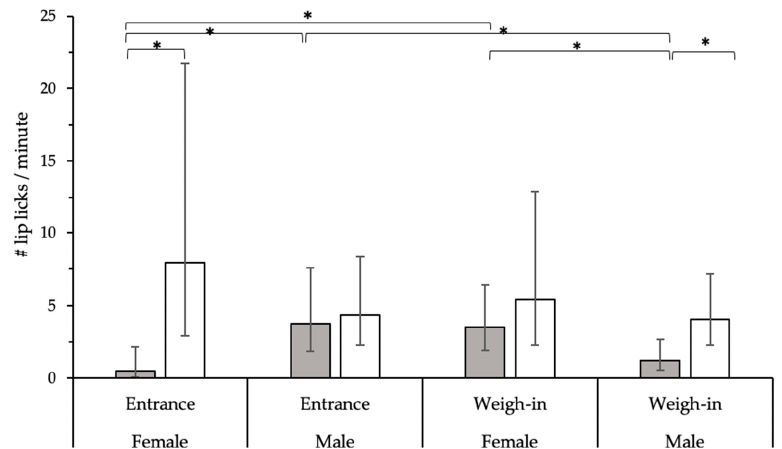
Figure 2. Differences in the rate of lip licking during post ‐ treatment visit for control (gray) and trained (white) dogs varying in dog sex and phase of clinic entrance. A higher rate of lip licks (95% CI) was displayed in trained (white) females compared to control (gray) females during entrance and in trained males compared to control males during weigh ‐ in; (mixed Poisson regression, * p < 0.05).